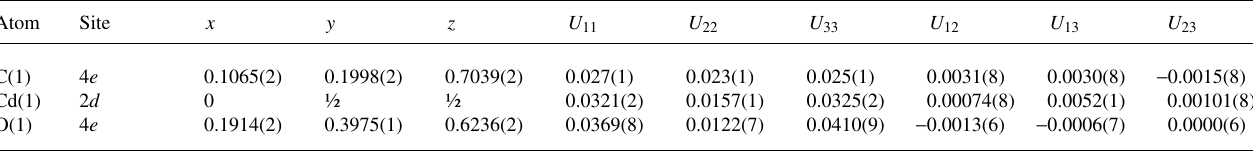
Table 3. Atomic coordinates and displacement parameters (in Å 2 )